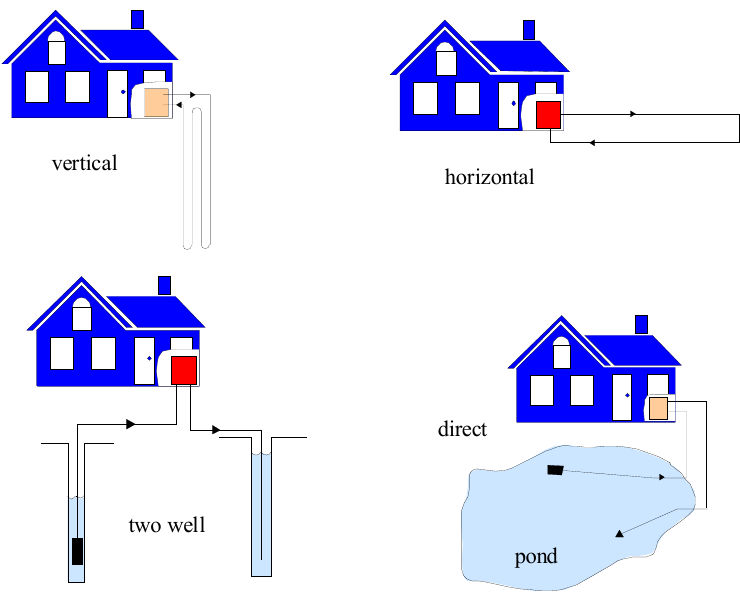
Figure 10. Typical closed and open loop geothermal heat pump